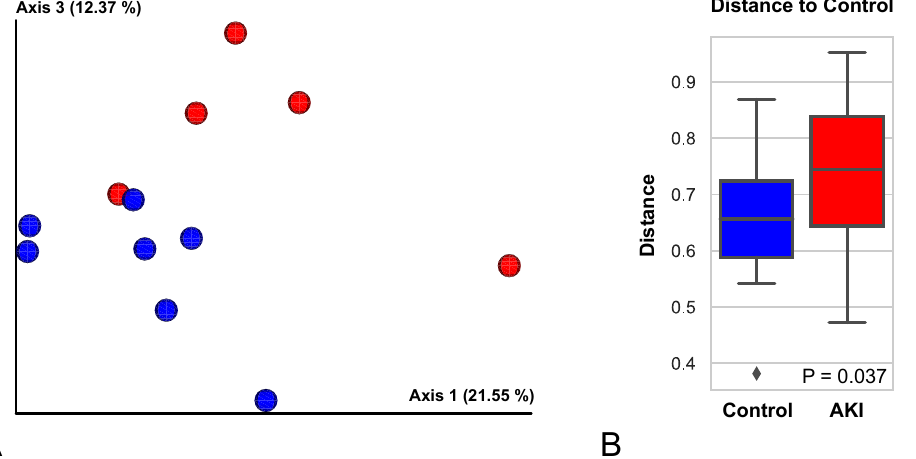
Figure 4. Proteome Composition Distinguishes Urinary Exosomes of V-AKI Patients and Controls. ( A ) Principal coordinates analysis of sample proteomes. The Bray-Curtis distance metric was used to calculate differences between sample proteomes and a principal coordinates plot is shown. Separation along axes 1 and 3 were observed between AKI samples (red) and control samples (blue). ( B ) Boxplot summarizing Bray-Curtis distance between control and AKI samples. Statistical separation between AKI and control samples shown in ( A ) was tested using a permutational analysis of variance test (PERMANOVA). Boxplots are shown summarizing the results when comparing distances of control or AKI samples to control